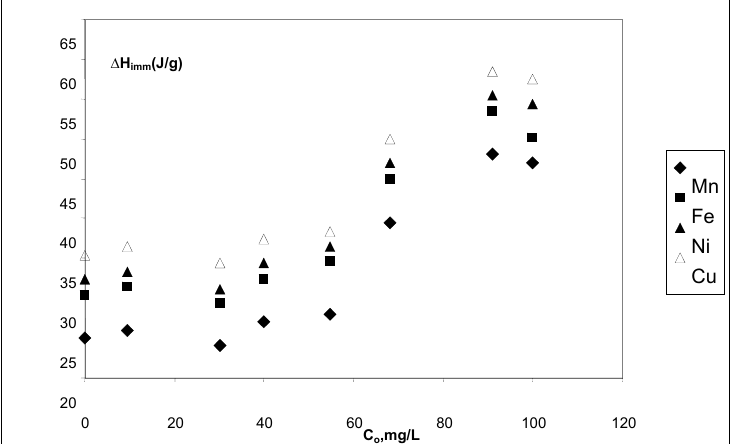
Figure 5. Immersion enthalpies for Mn 2+ , Fe 2+ , Ni 2+ and Cu 2+ aqueous solutions ions concentration at pH 5.1. T = 298